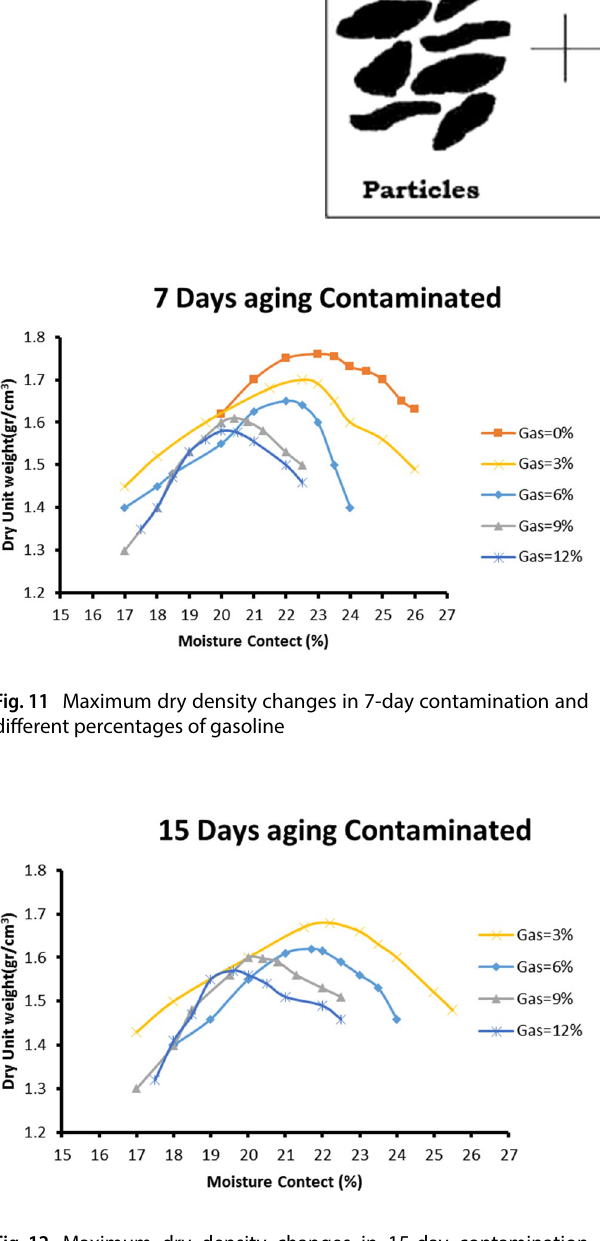
Fig. 14 Relationship between maximum dry density and gasoline content at the different